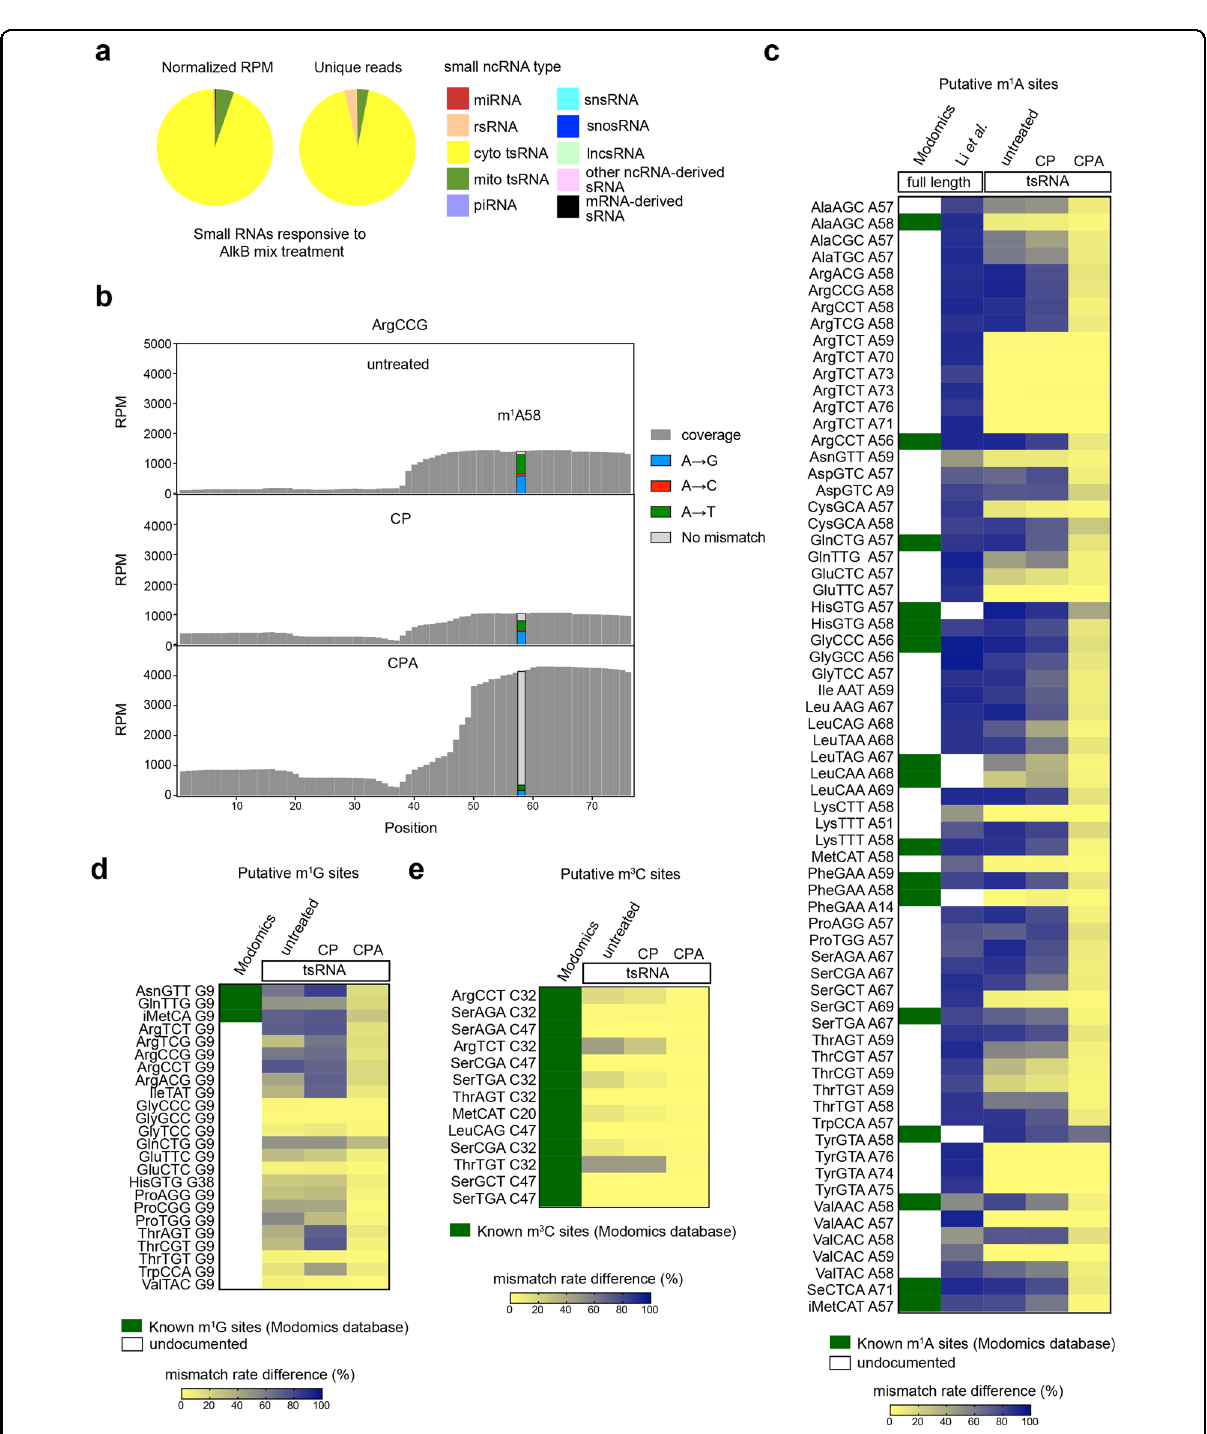
Fig. 4 Methylome of sRNAs. a Pie diagrams showing the distribution of different types of sRNAs responsive to AlkB mix treatment (unique reads that were highly detected in CPA group, but lowly detected in CP group with the fold change >30, n = 2). b Misincorporation and coverage plot for putative m 1 A sites identi fi ed in this study. c Estimation of m 1 A methylome by the mismatch frequency at A sites of tRNAs. Treatment of AlkB mix demethylates m 1 A and reduces TGIRT-induced misincorporation at m 1 A sites. The known m 1 A sites (Modomics database) and putative m 1 A sites of full-length tRNAs revealed by Li et al. 40 are shown accompanied by the m 1 A site of tsRNAs revealed by this study. d The m 1 G sites of tsRNAs revealed by CP-seq and CPA-seq. e The m 3 C sites of tsRNAs revealed by CP-seq and